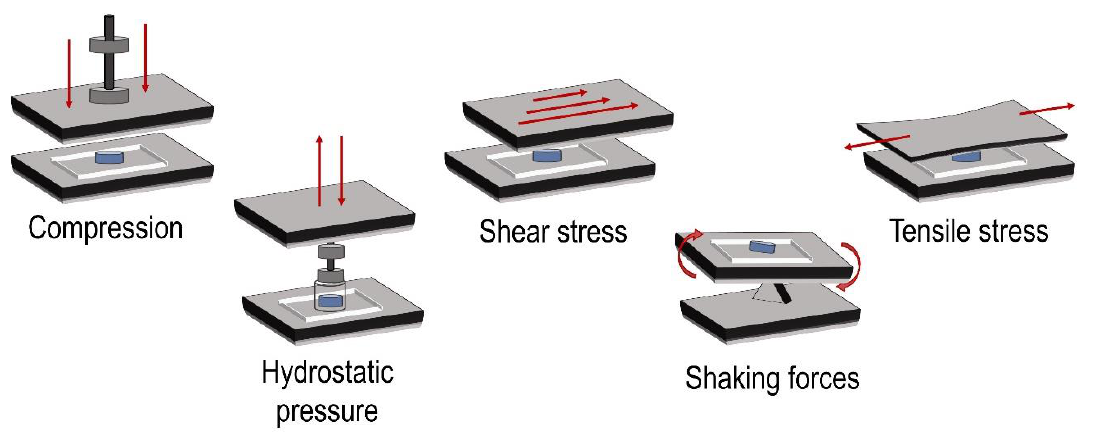
Figure 2. Types of mechanical stimuli experienced by the cells. Stem cell cultures, used in tissue engineering, undergo biophysical stimulation in order to promote chondrogenesis and recreate the dynamic environment within the joint.